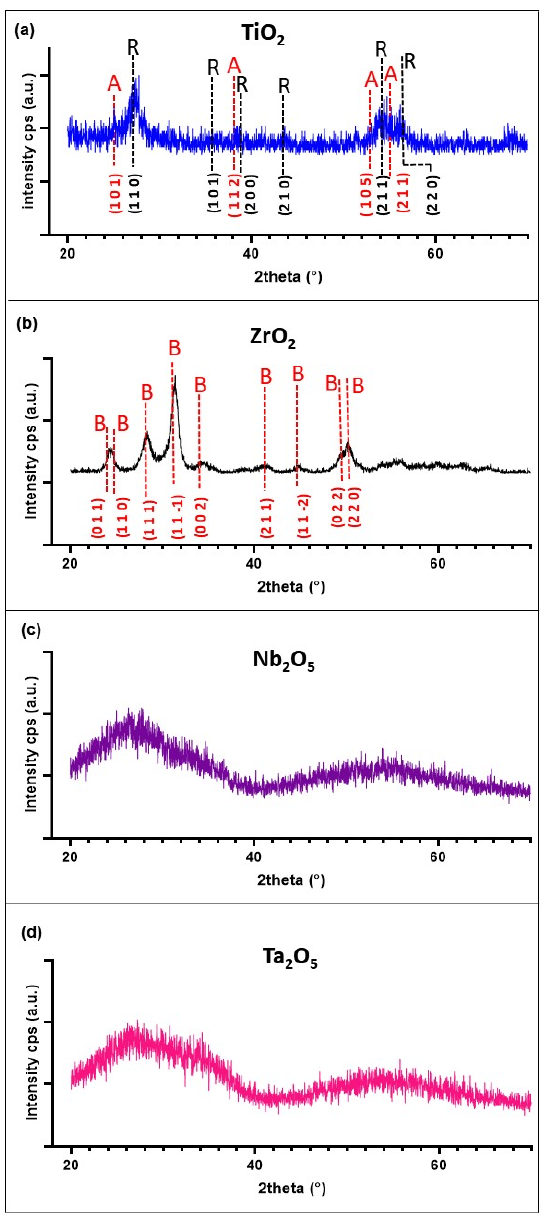
Figure 4. Representative grazing incidence XRD patterns of ( a ) TiOx, ( b ) ZrOx, ( c ) NbOx, and ( d ) TaOx coatings. In Figure 3a, the A and R stand for the expected XRD pattern for Anatase and Rutile crystalline phases of TiO 2 , respectively. In Figure 3b, the B stands for the expected XRD pattern for the Baddeleyite crystalline phase of ZrO 2